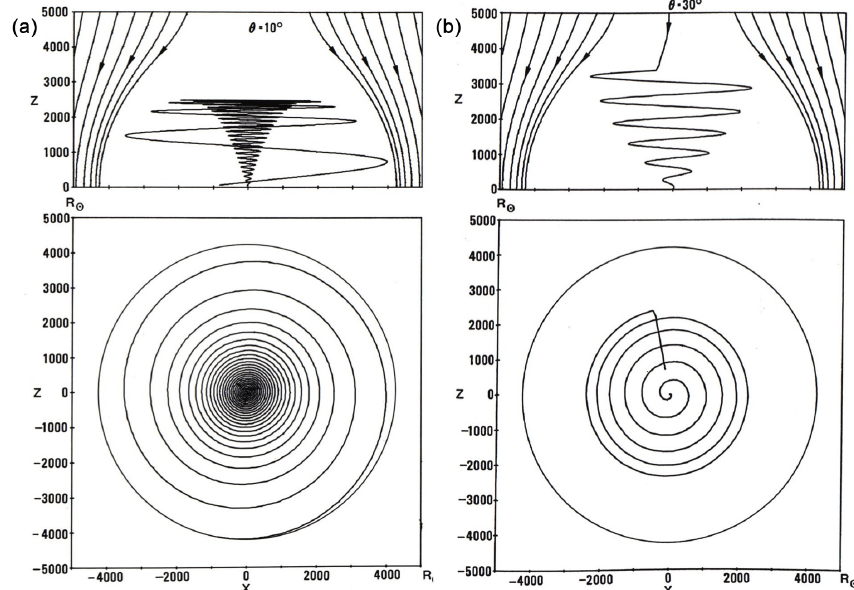
Figure 12. Two models of the heliosphere (the northern hemisphere). (a) A confined case. (b) An open